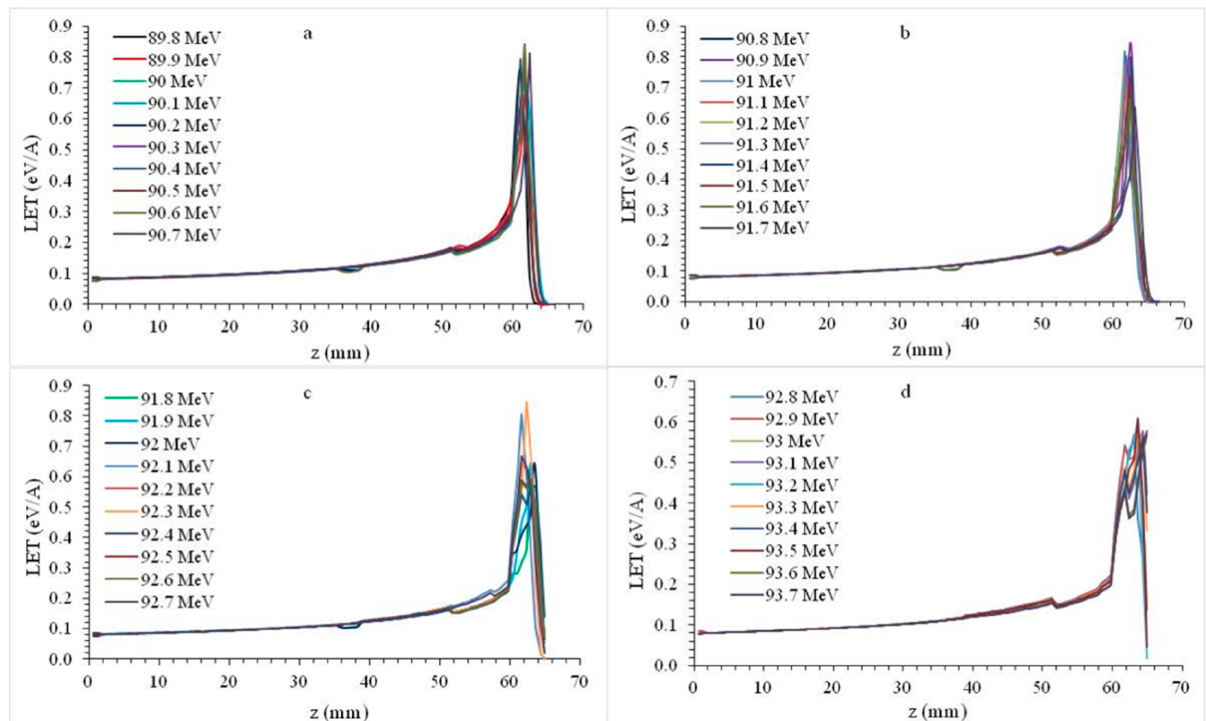
Figure 4. Bragg curves formed by 89.8–93.7 MeV ( a – d ) energy protons in molar plate phantom.